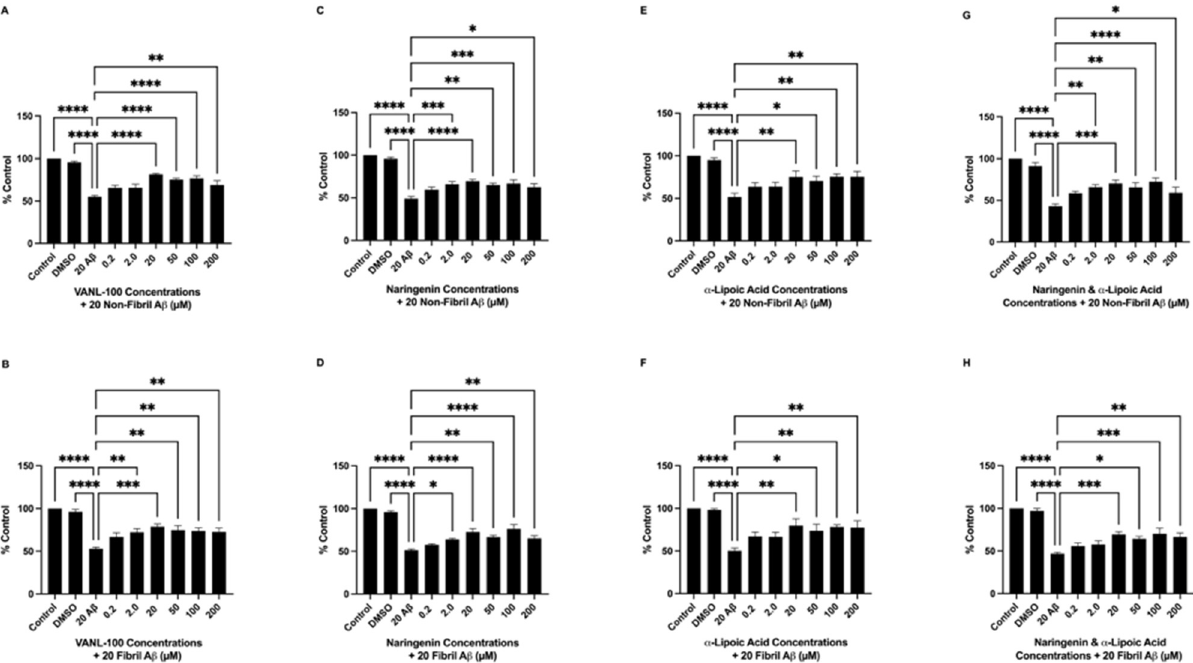
Figure 4. Viability of SH-SY5Y cells pre-treated with VANL-100, NAR, ALA, or NAR + ALA for 24 h followed by 24-h treatment with A β 25–35 . Cell viability, represented as % control, is shown on the y-axis, and antioxidant concentrations are displayed on the x-axis. The bars represent the mean ± SEM of six independent experiments. ( A , B ) VANL-100 + non-fibril and fibril A β 25–35 , re- spectively. ( C , D ) NAR + non-fibril and fibril A β 25–35 , respectively. ( E , F ) ALA + non-fibril and fibril A β 25–35 , respectively. ( G , H ) NAR + ALA + non-fibril and fibril A β 25–35 , respectively. Statistical signif- icance vs. A β was assessed using one-way ANOVA. * p <0.05; ** p < 0.01; *** p < 0.001; **** p <